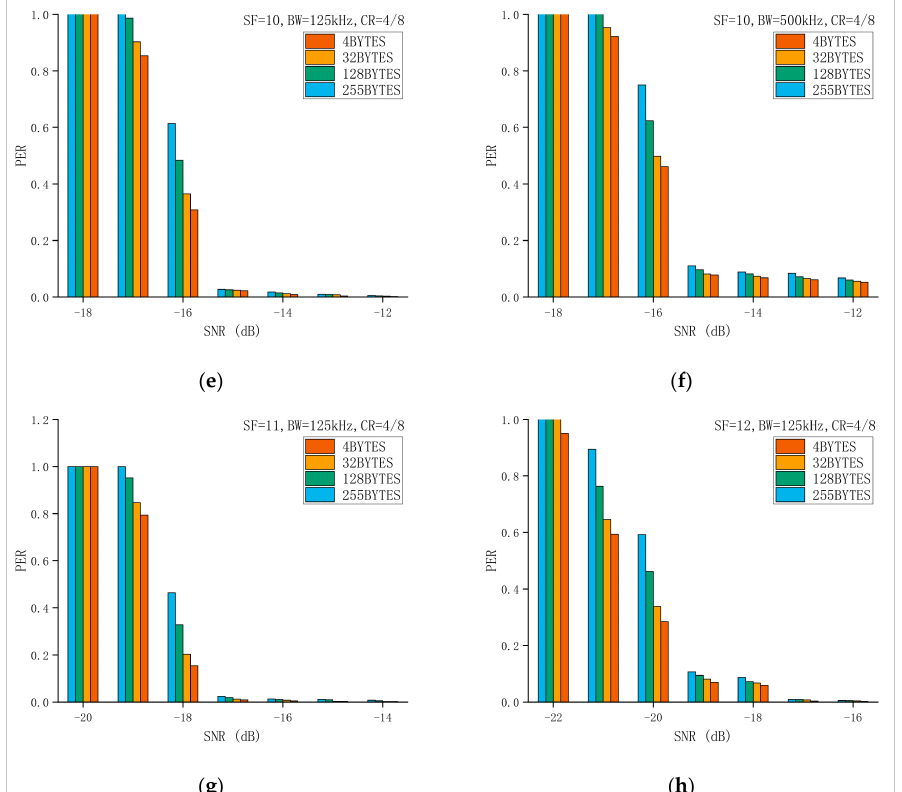
Figure 9. The impact of different packet lengths on the packet reception performance of LoRa. ( a – h ) shows the results of the Packet Error Ratio for different packet